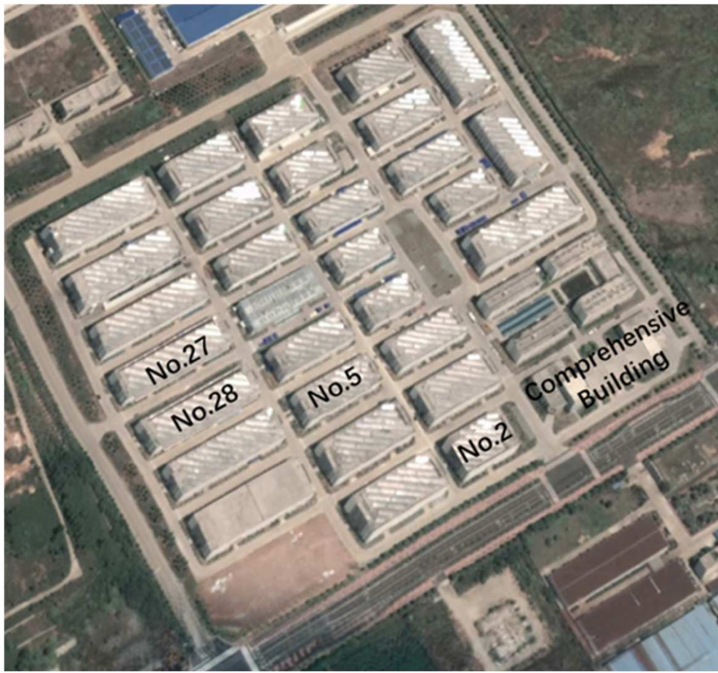
Figure 12. Map of experimental park.